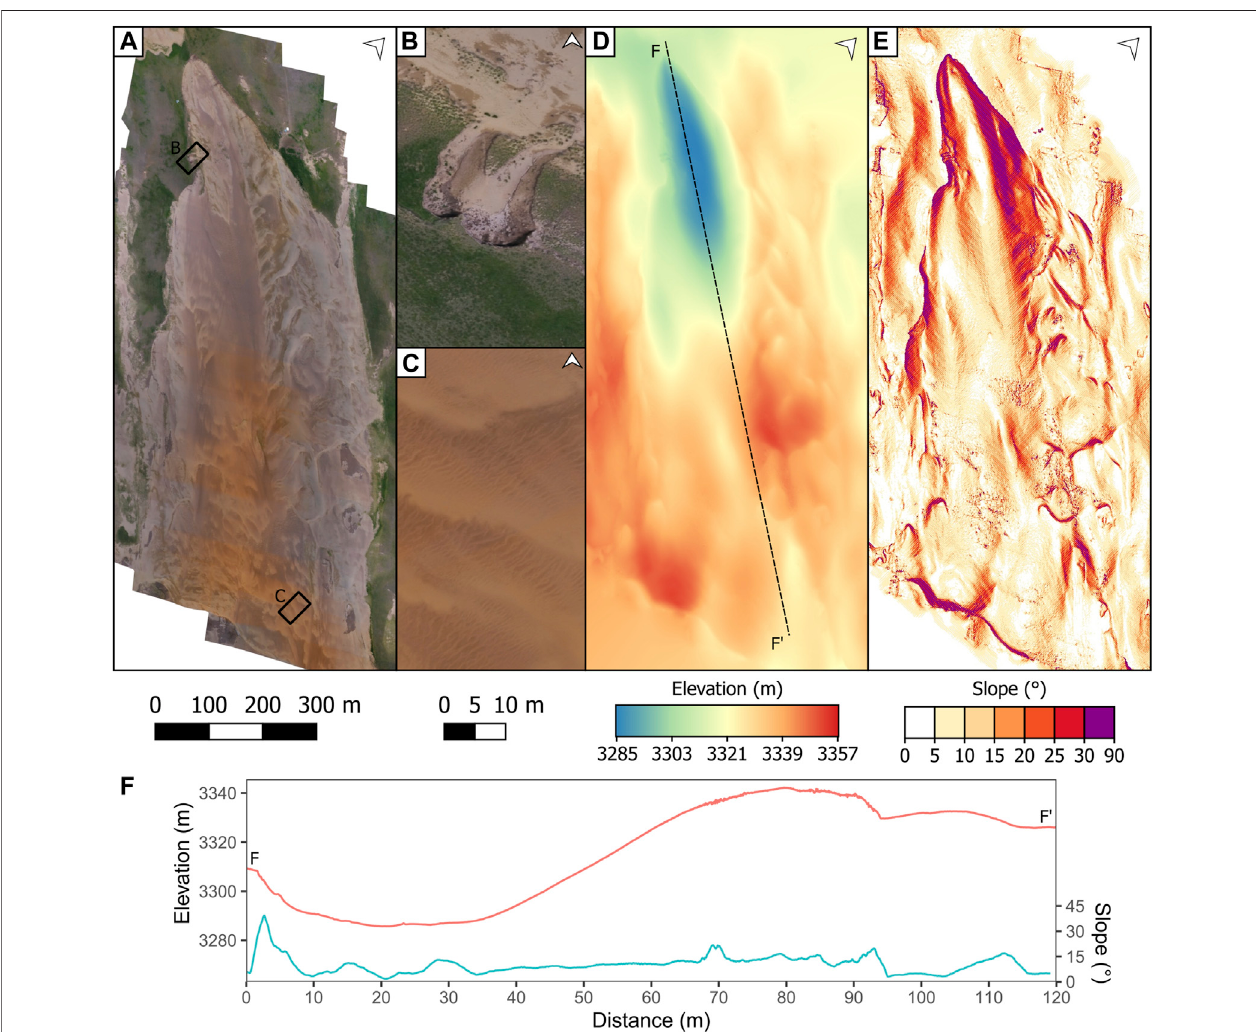
FIGURE9 | ( A ) Acomplexmega-blowout with( B ) multiple merging erosionalhollows and ( C ) evidence ofactive sediment transport. The ( D ) digital elevation model and ( E ) slope map show a ( F ) low gradient incline in the hollow-lobe transition (vertical exaggeration of 2.5). Coordinates of the top-left corner of the bounding box: 35.89694N, 100.28670E; bottom-right corner: 35.89114N,